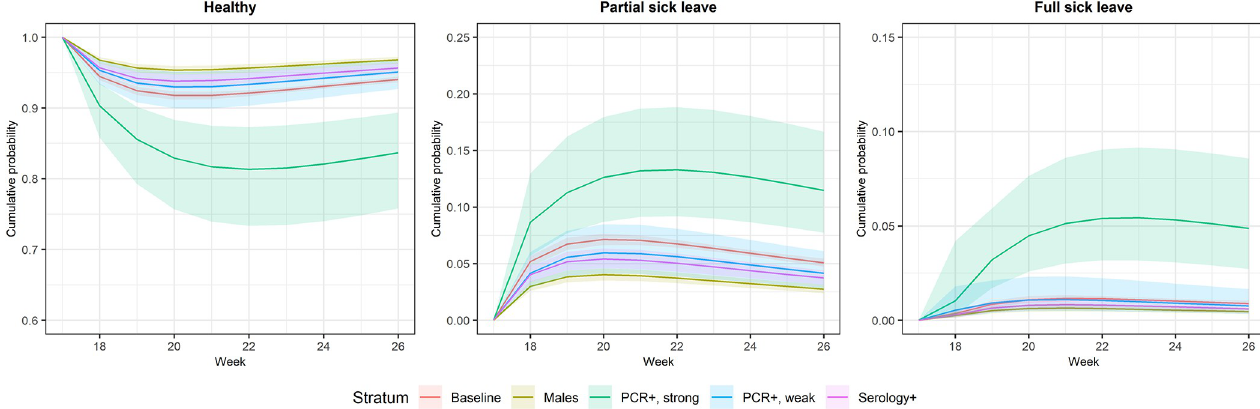
Fig 2. Standardized transition probabilities by calendar week.